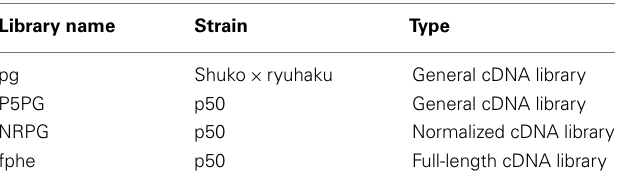
Table 1 | List of the pheromone gland cDNA libraries in the B. mori EST